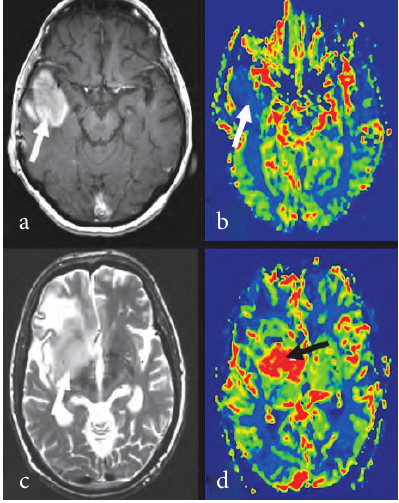
Fig. 1.(a - b) A 71-year-old man with CNS lymphoma. (a) Axial post-contrast T1WI, and (b) CBV map of perfusion-weighted images showing homogeneous contrast enhancement (arrow, a), and low CBV (arrow, b). (c - d) A 65-year-old man with glioblastoma multiforme. (c) T2WI, and (d) CBV map of perfusion-weighted images showing high signal intensity on T2WI and high CBV on PWI (arrow).